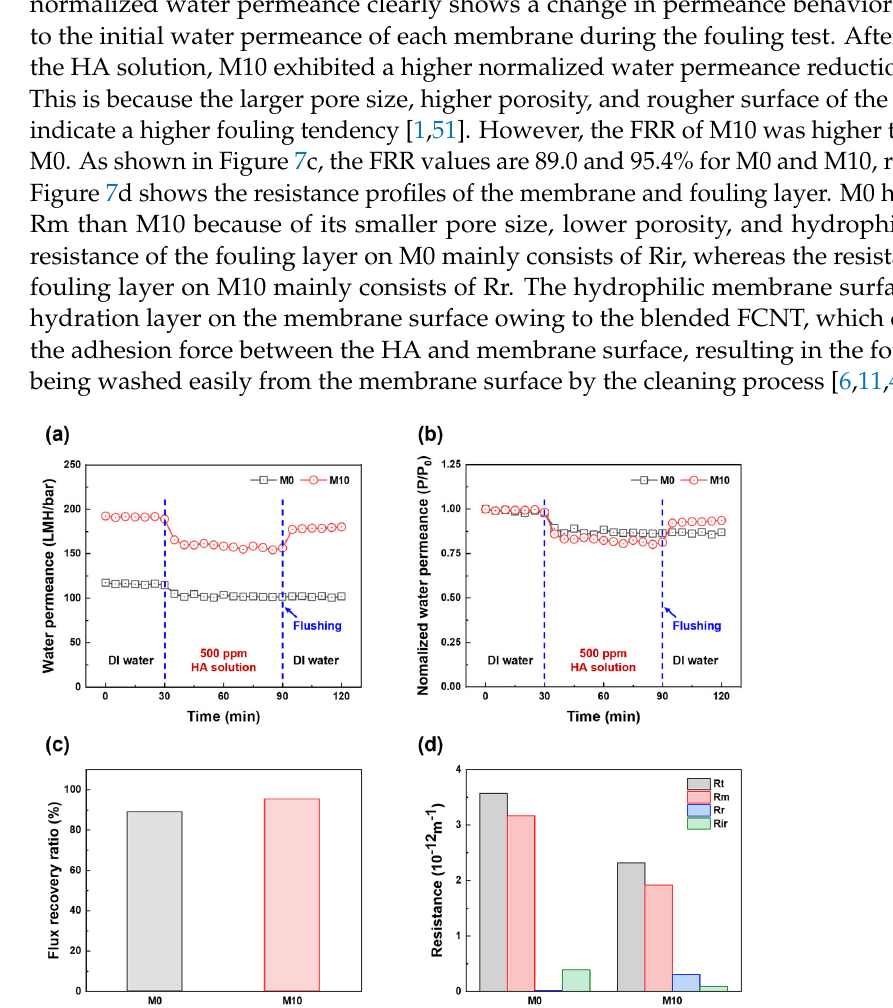
Figure 8. Schematic illustration of filtration and antifouling mechanisms of PES and FCNT/PES nanocomposite HF membranes. 4. Conclusions In this study, we developed a high filtration and antifouling PES HF membrane for the UF process by blending FCNT into the membrane. The FCNT were prepared by acid functionalization of pristine CNT to increase their hydrophilicity, dispersibility, and sta ‐ bility. An FCNT/PES nanocomposite HF membrane was fabricated via a dry ‐ jet wet